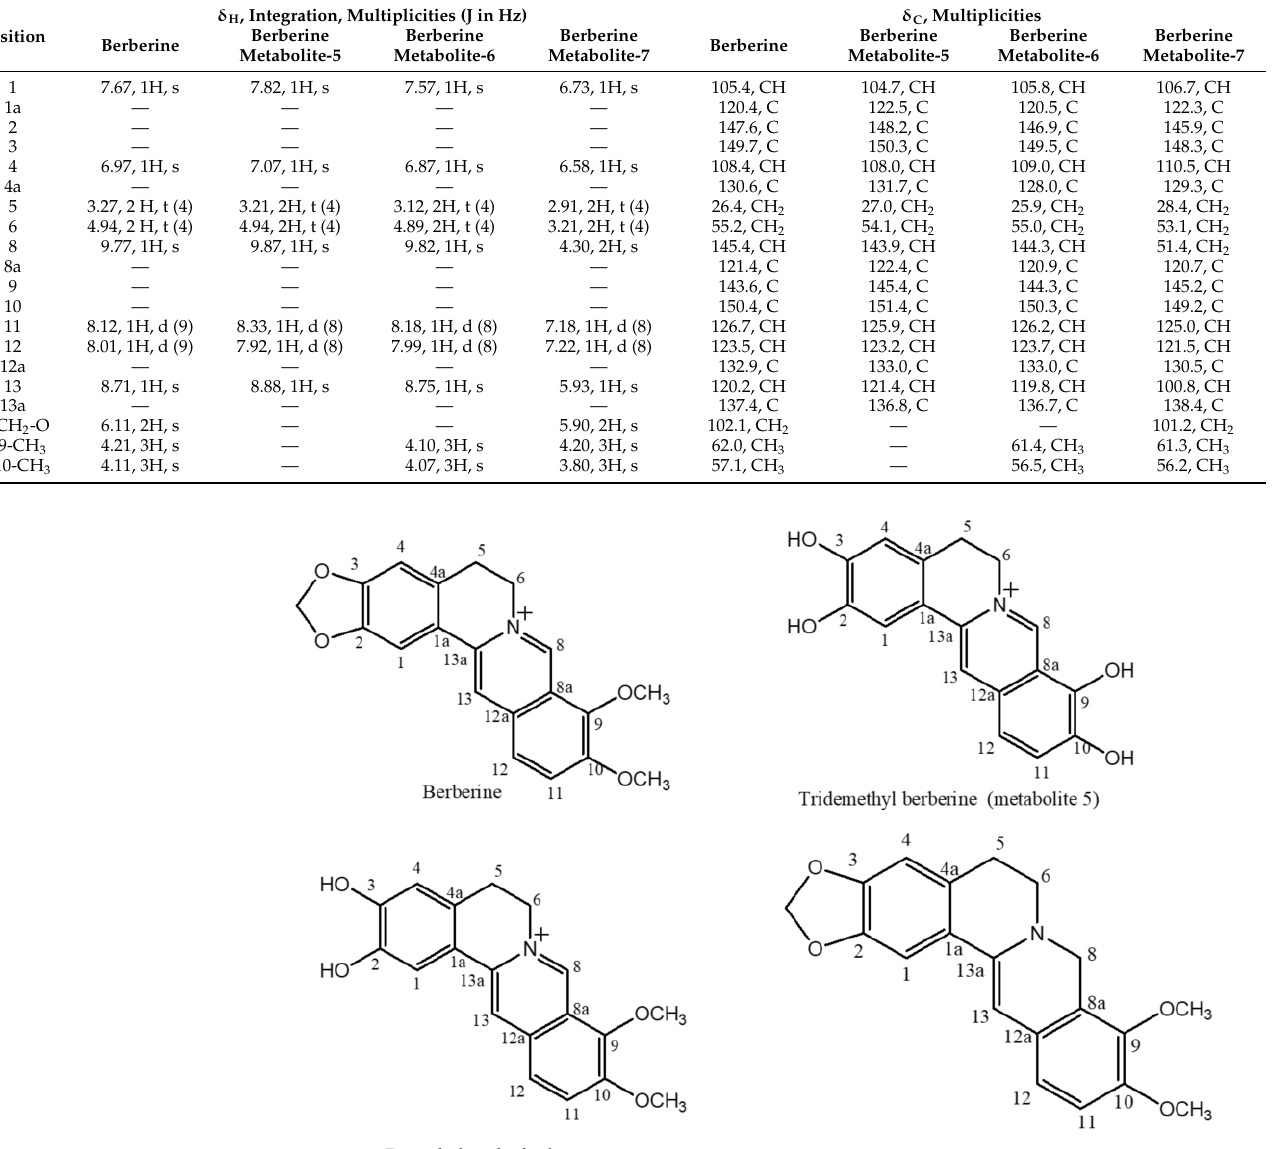
Table 2. Results of 1 H NMR and 13 C NMR analysis of berberine metabolites 5 – 7 and berberine [27] (in MeOD, 400 MHz).